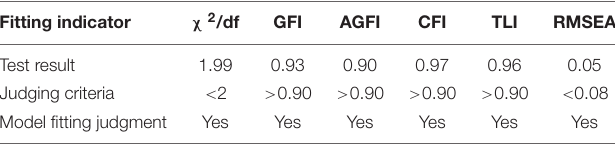
TABLE 4 | Model fitting result